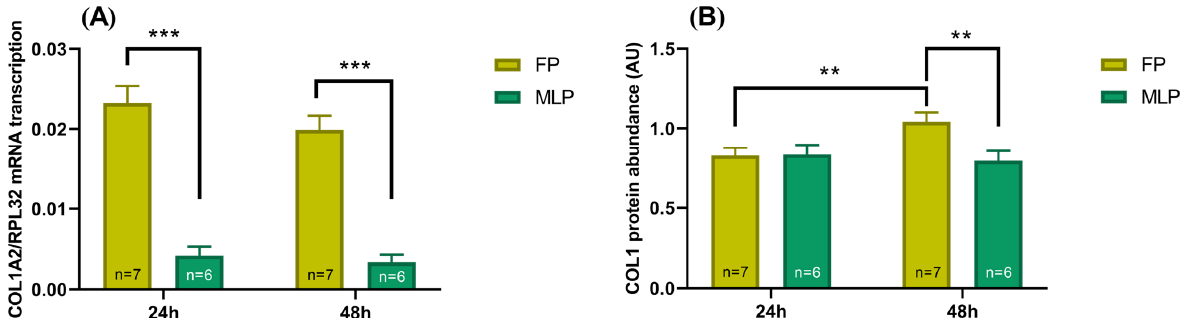
Figure 1. Effect of time of treatment (24 or 48 h) and estrous cycle phase (follicular phase—FP; mid- luteal phase—MLP) on relative collagen type I alpha chain ( COL1A2 ) mRNA transcription ( A ), and COL1 relative protein abundance ( B ) in equine endometrial explants. The results are independent of MPO and NOSC treatment, shown as the least square means ± SEM and considered significant at p < 0.05. Asterisks above the connecting line represent significant differences between treatments (** p < 0.01; *** p < 0.001).